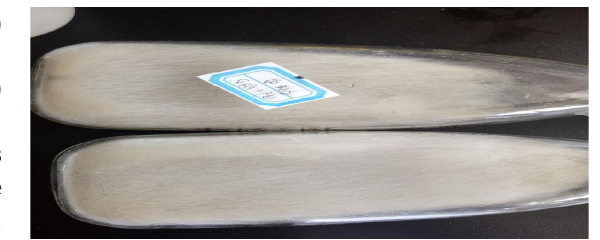
Figure 1: Purity detection of the Phanerochaete chrysosporium